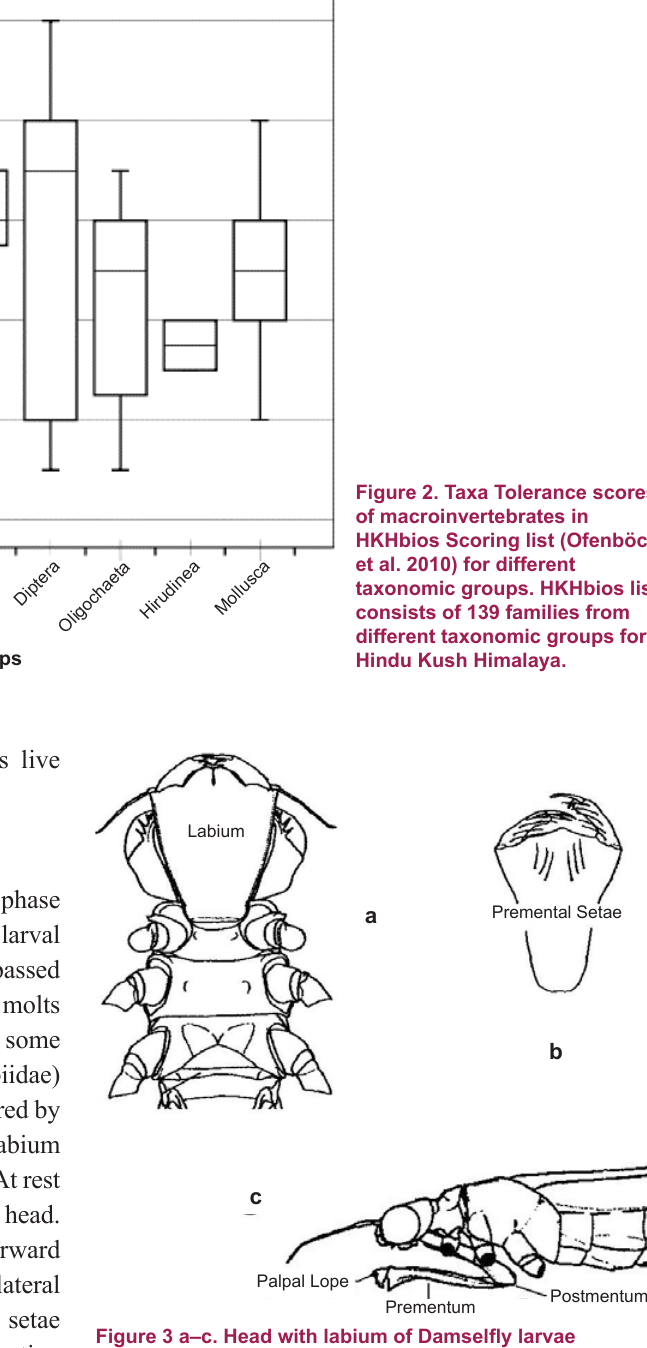
Figure 3 a–c. Head with labium of Damselfly larvae a - ventral view of Euphaeidae; b - dorsal view of labium of Coenagrionidae showing the premental setae; c - lateral view showing the resting position of